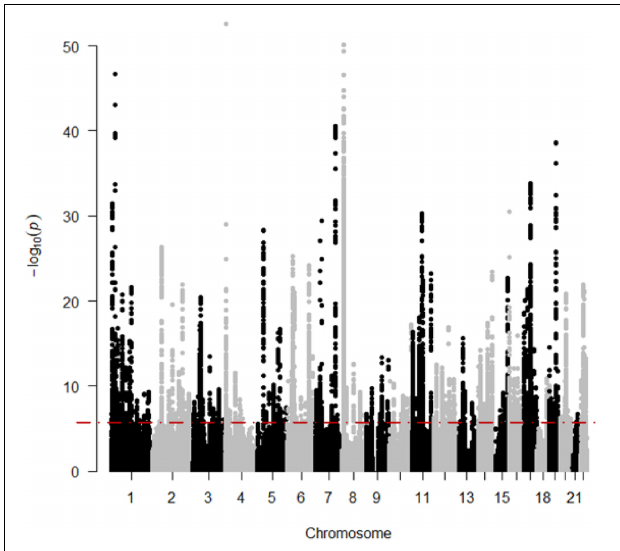
FIGURE 3 | The results of BMD-related genes based on SMR. The red line means “Significant threshold”.